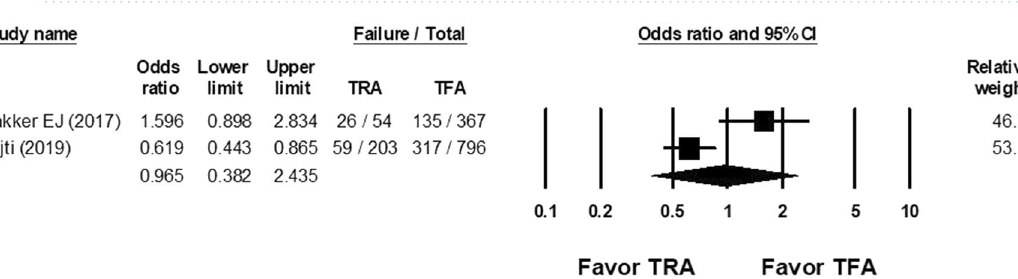
Figure 2. Forest plots of the overall odds ratio (OR) of procedural success rate of chronic total occlusion (CTO) percutaneous coronary intervention (PCI) between the transradial access (TRA) and transfemoral access (TFA) groups from 6 studies. CI confidence interval, TRA transradial access, TFA transfemoral access.